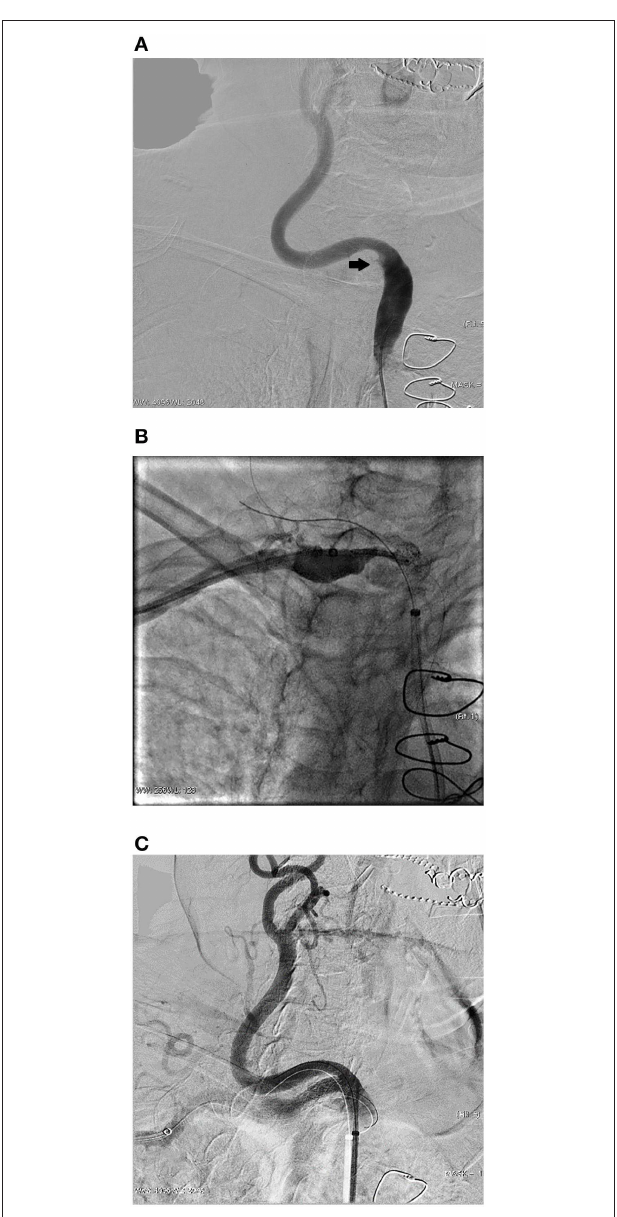
FIGURE 2 | A representative case of successful retrograde recanalization. This was an 84 years old female patient who presented with vertigo for 1 year. (A) Angiography shows occlusion of the right subclavian artery ostium. (B) After failed antegrade recanalization, we attempted retrograde recanalization via the brachial artery. An emboli protection device was placed in the right internal carotid artery. Angiography was performed before deploying a balloon expandable stent to confirm the accurate location. (C) Angiography shows the perfect position of the stent, which completely covered the lesion but did not affect the blood flow of the right carotid